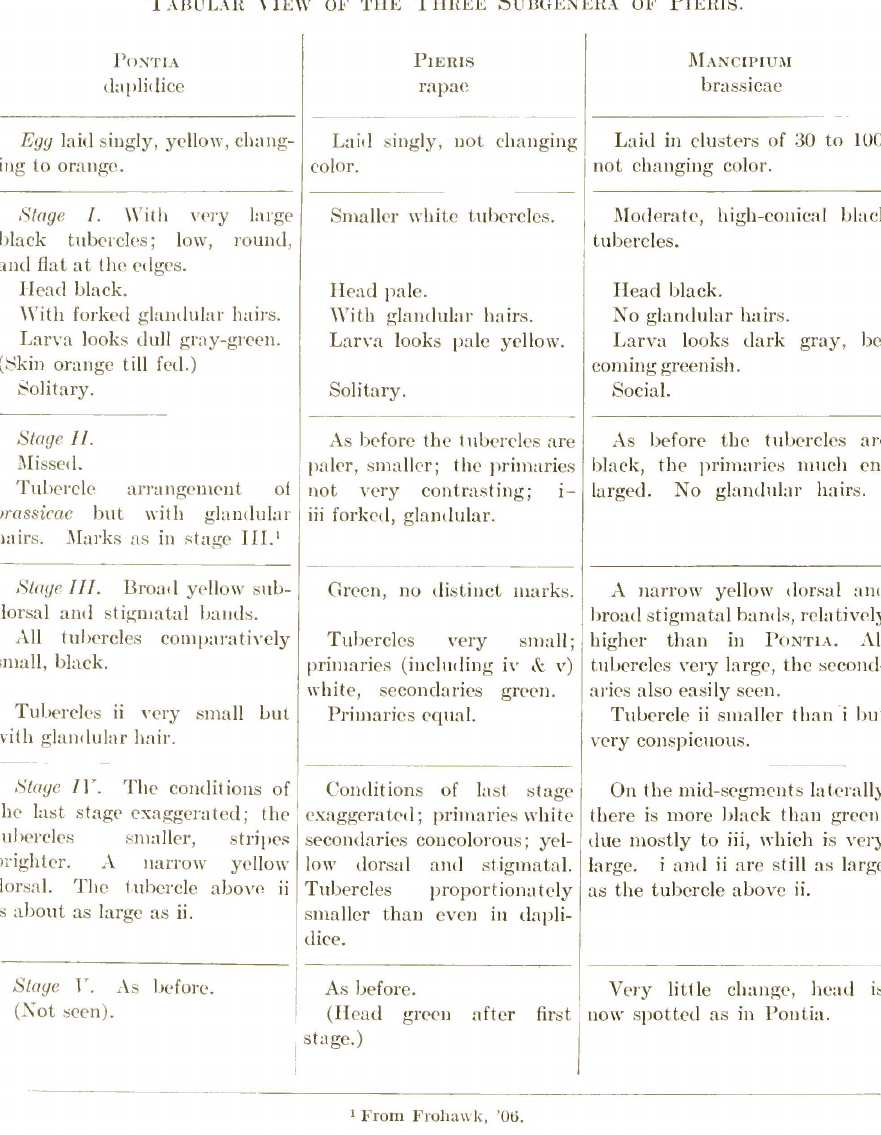
TABUL.\R \'JEW OF THE THREE SUBGENERA OF PIERIS .